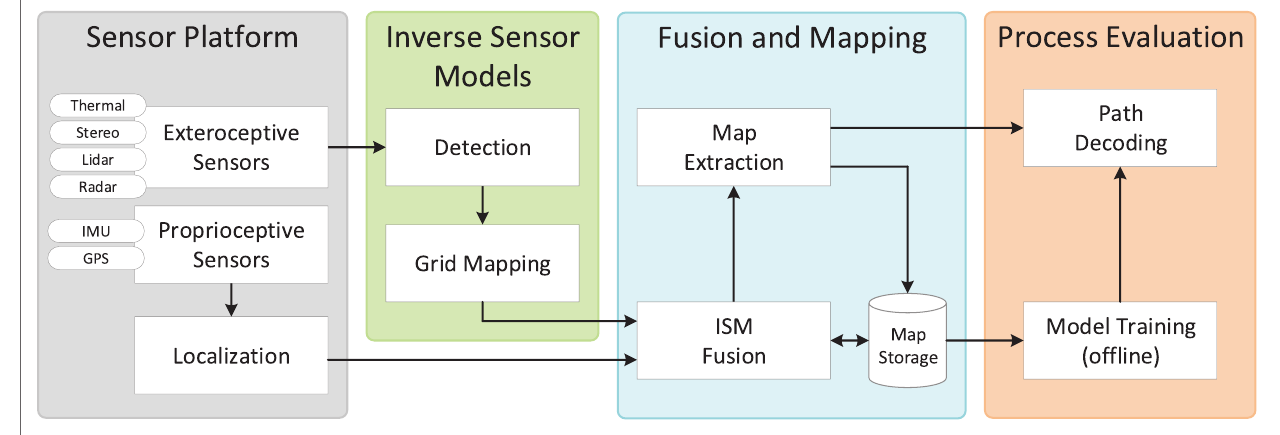
FIGURE 1 | System architecture including information